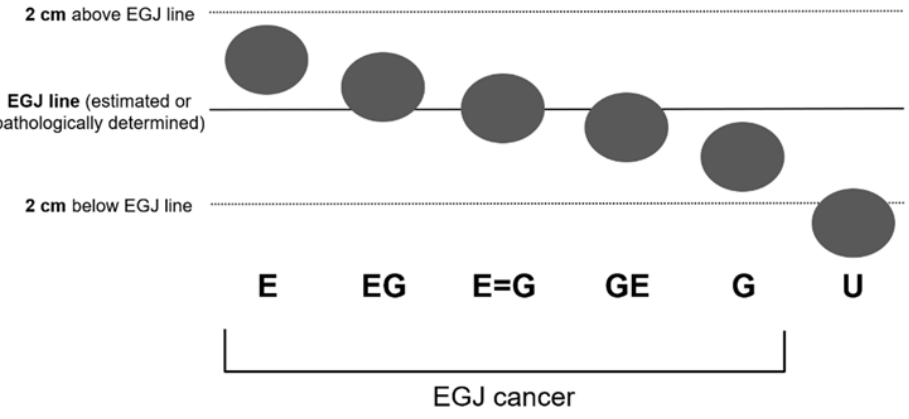
Figure 2. Classification of the epicenter of the tumor determined in relation to the distance from the esophagogastric junction. EGJ—esophagogastric junction.